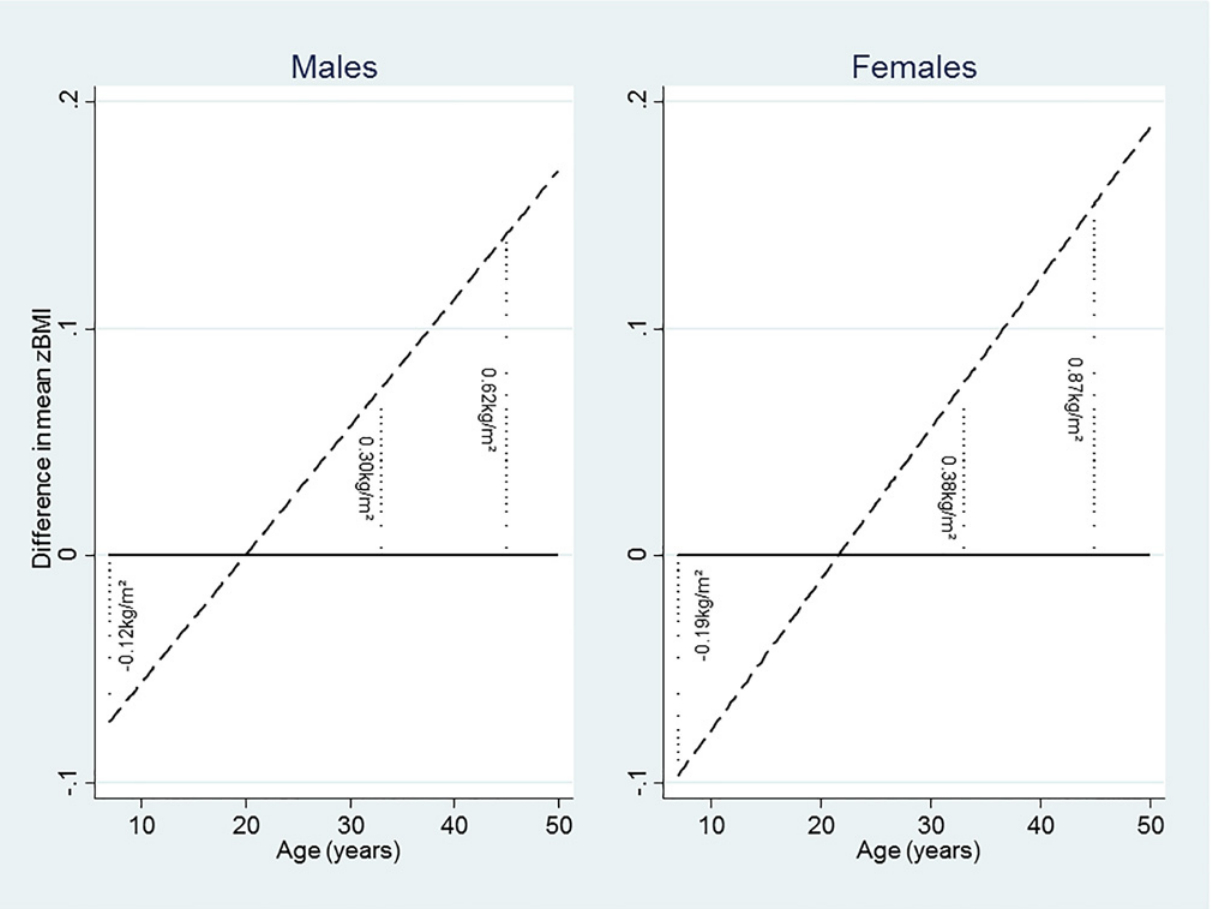
Fig 2. Difference in mean zBMI by childhood physical abuse † from fully adjusted models, males and females * . Footnotes: † participant report in adulthood (45y) that they had been physically abused by a parent during their childhood before 16y, i.e. punched, kicked or hit or beaten with an object, or needed medical treatment. * Difference in mean zBMI by childhood physical abuse estimated from fully adjusted models; showing equivalent differences in BMI (kg/m 2 ) at 7y, 33y and 45y. The positive linear association of zBMI gain with age and physical abuse is given as ~0.006/y (males) and ~0.007/y (females) in Table